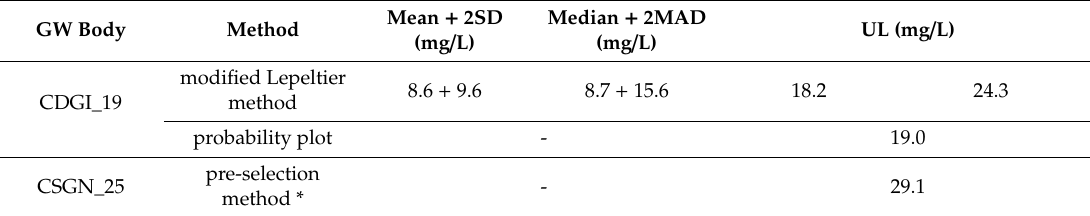
Table 8. Estimated Mean + 2SD and Median + 2MAD ranges (for modified Lepeltier method) and the upper limits of ranges of ambient background concentrations (UL) of nitrates (NO 3 ) obtained by selected methods. EU Drinking Water Standard for NO 3 is 50 mg NO 3 /L.